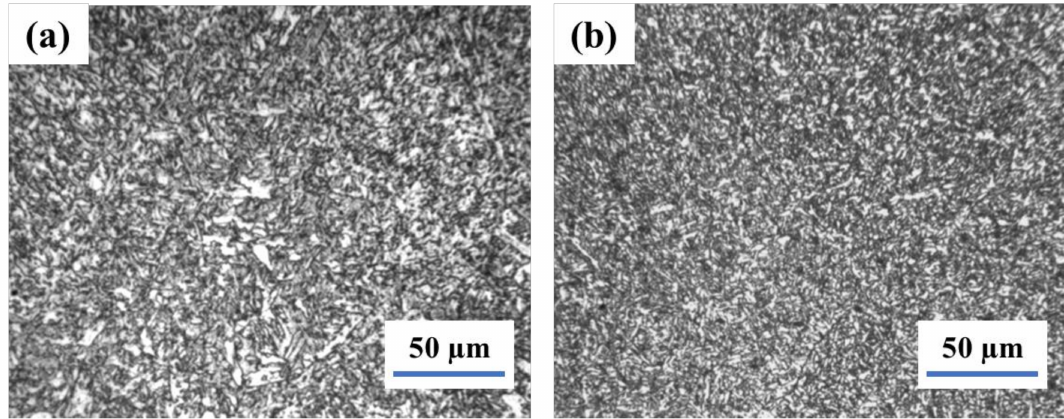
Figure 1. The microstructure of welding joint in as weld − weld ( a ) and HAZ ( b ).